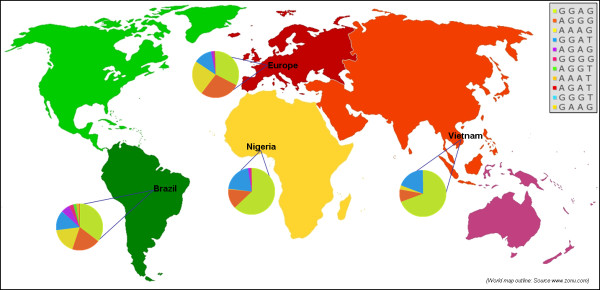
Distribution ofFCN2haplotypes in world populations.